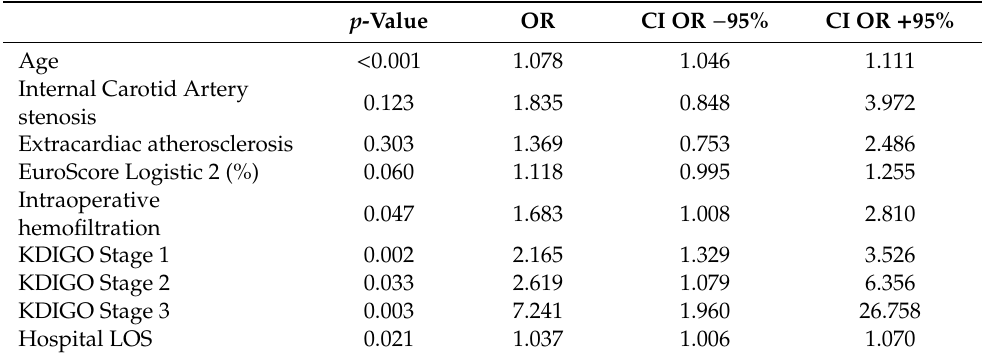
Table 4. Multivariable analysis for POD development after CABG.